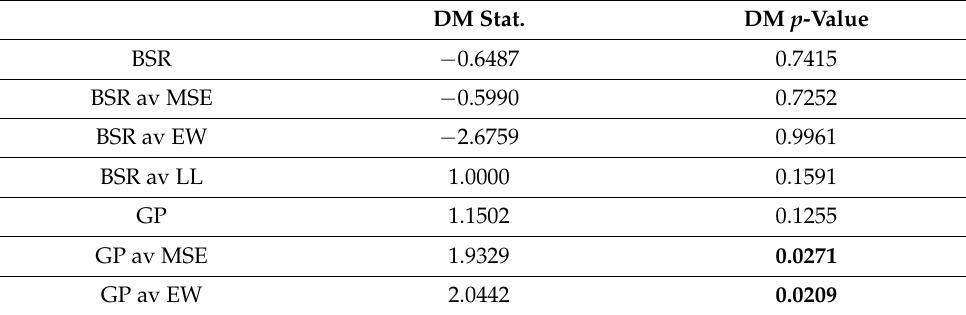
Table 7. Results of the Diebold–Mariano test for recursive (“rec”) vs. fixed (“fix”)